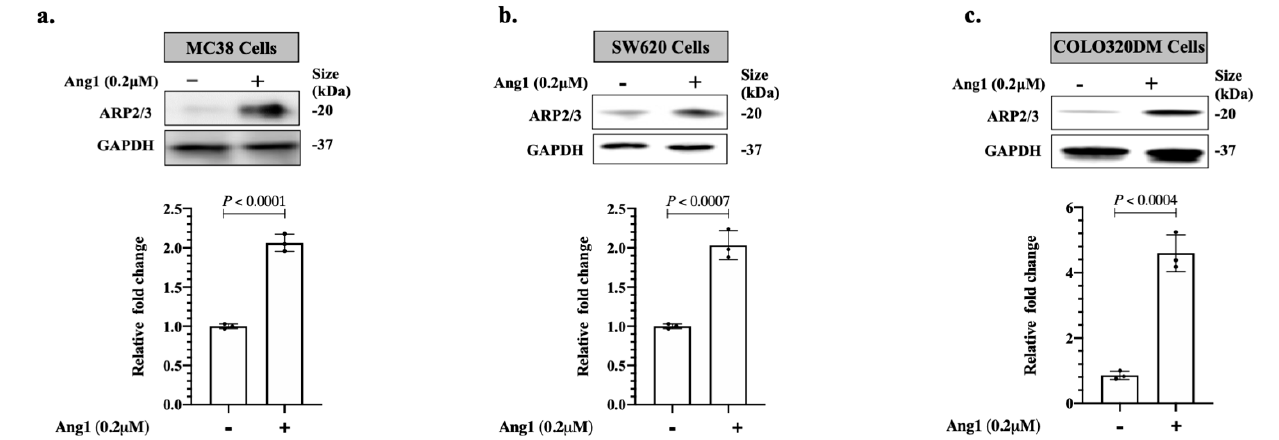
Figure 1. Ang1 induces ARP2/3 expression in colorectal cancer cells in vitro. ( a – c ) Western blotting of ARP2/3 expression in colorectal cancer (COLO320dm, SW620 and MC38) cells in the presence or absence of Ang1 (top panel). The intensity of ARP2/3 bands (n = 3) were quantified and normalized against GAPDH using ImageJ and represented as a fold change (bottom panel).